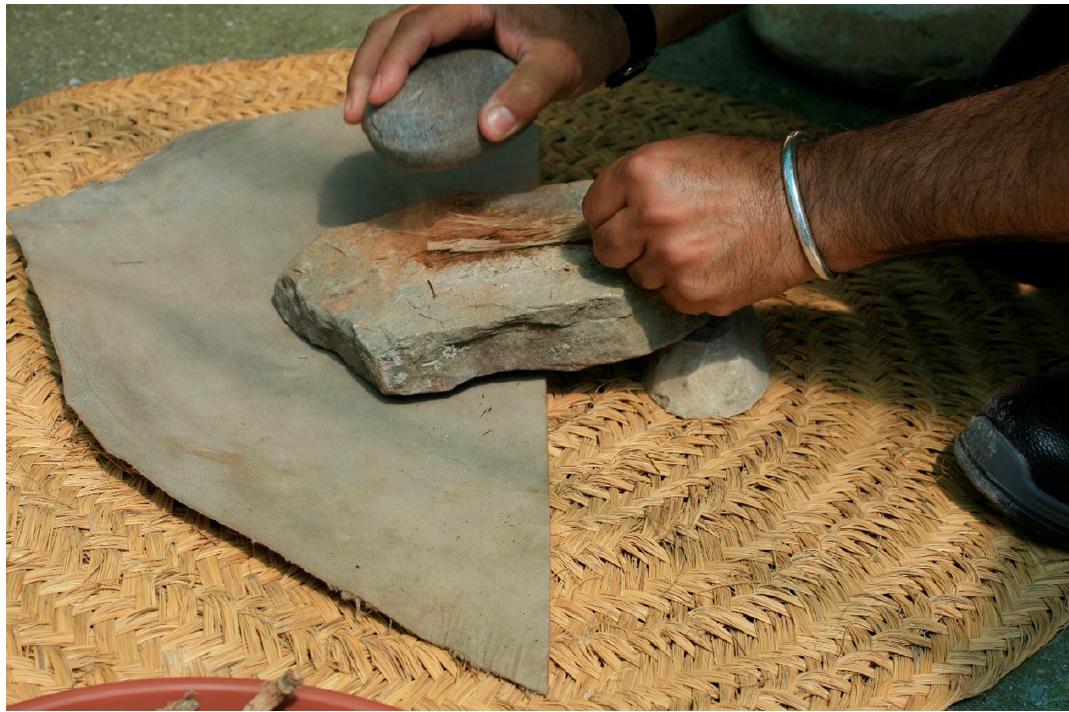
Figure 8. Grinding dried cattail roots on an experimental grinding stone.